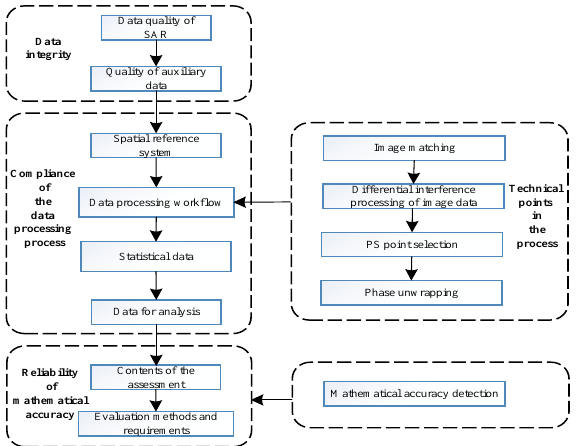
Figure 1. The Technical Route of Quality Inspection of the Deformation Monitoring Result of